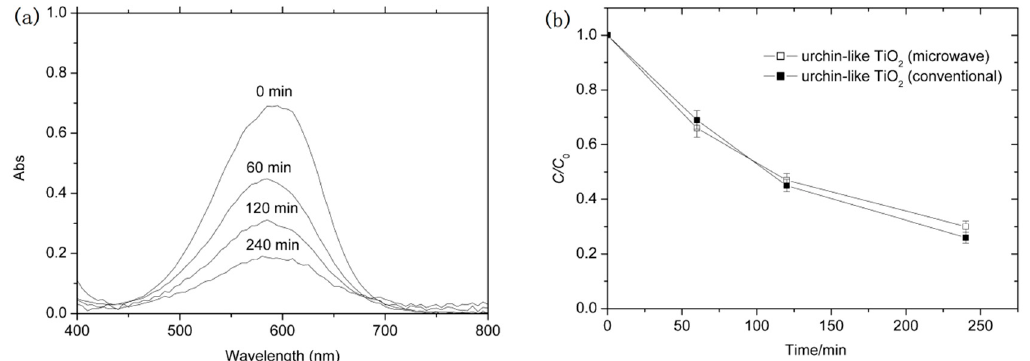
Figure 6. ( a ) The absorbance spectra of methyl blue as a function of irradiation time when the TiO 2 samples synthesized at 135 °C under 5 min microwave irradiation is used as a photocatalyst; ( b ) Photodegradation of methyl blue for urchin-like TiO 2 synthesized by the microwave-assisted method and conventional solvothermal method under UV-Vis